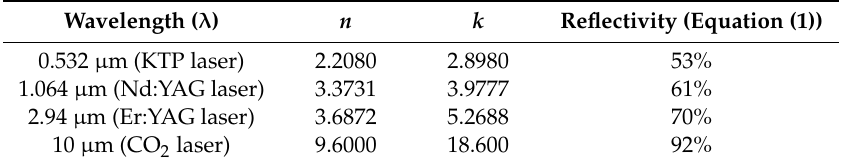
Table 2. Titanium optical